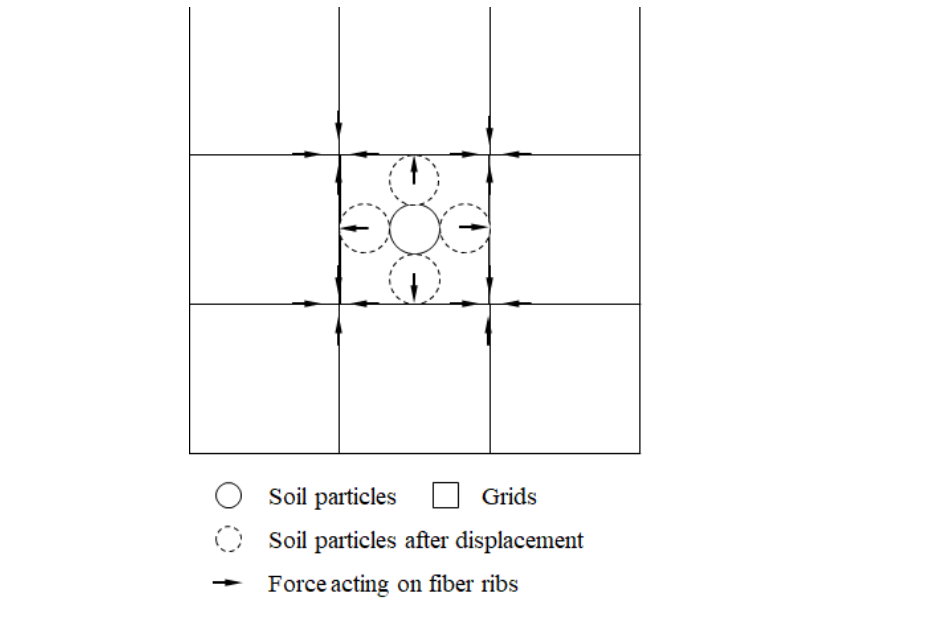
Figure 10. Schematic diagram of the force diffusion.